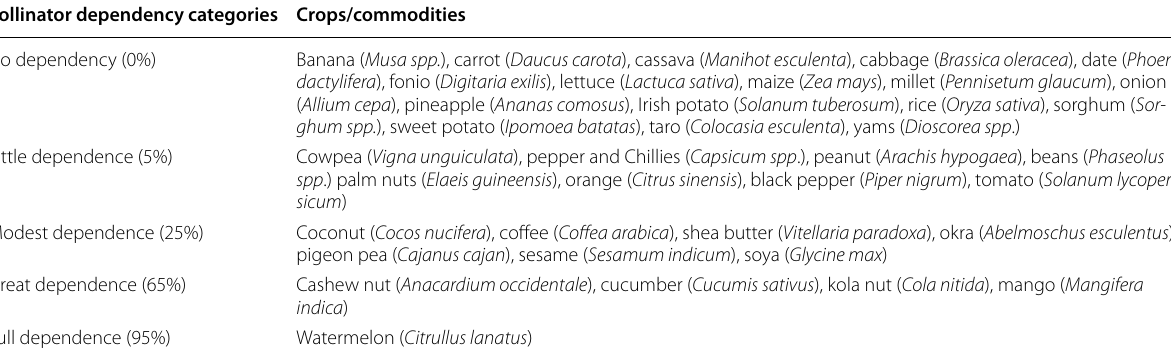
Table 1 Crops used for this study classified by pollinator dependency categories Pollinator dependency categories